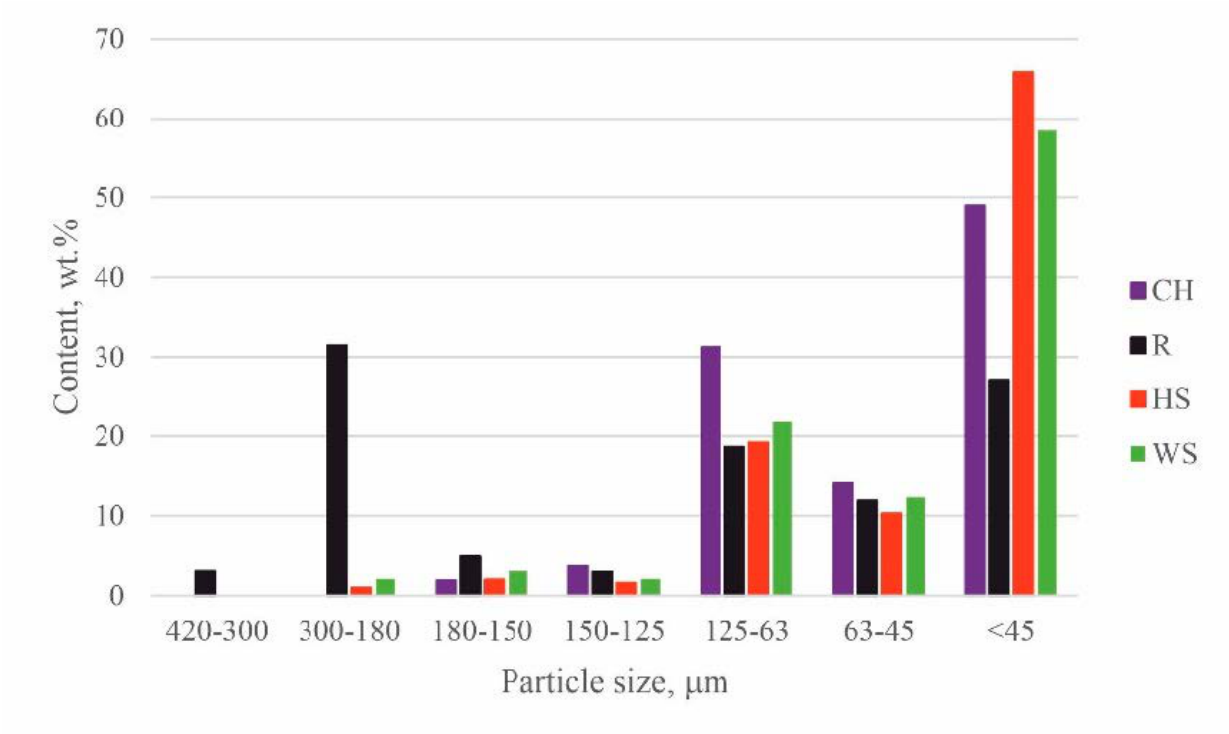
Figure 1. The grain size analysis